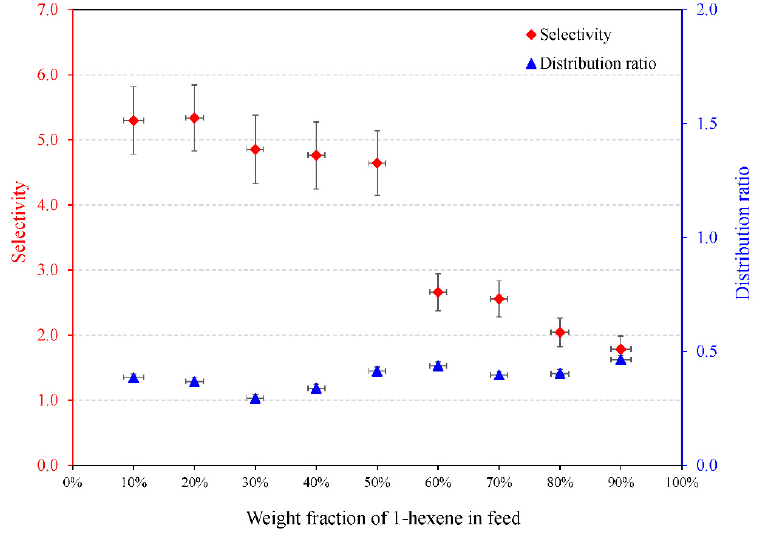
Figure 5. Variation of the selectivity and the distribution ratio with toluene weight fraction in the feed for {1-hexene (1) + toluene (2) + DES #1 (3)}.